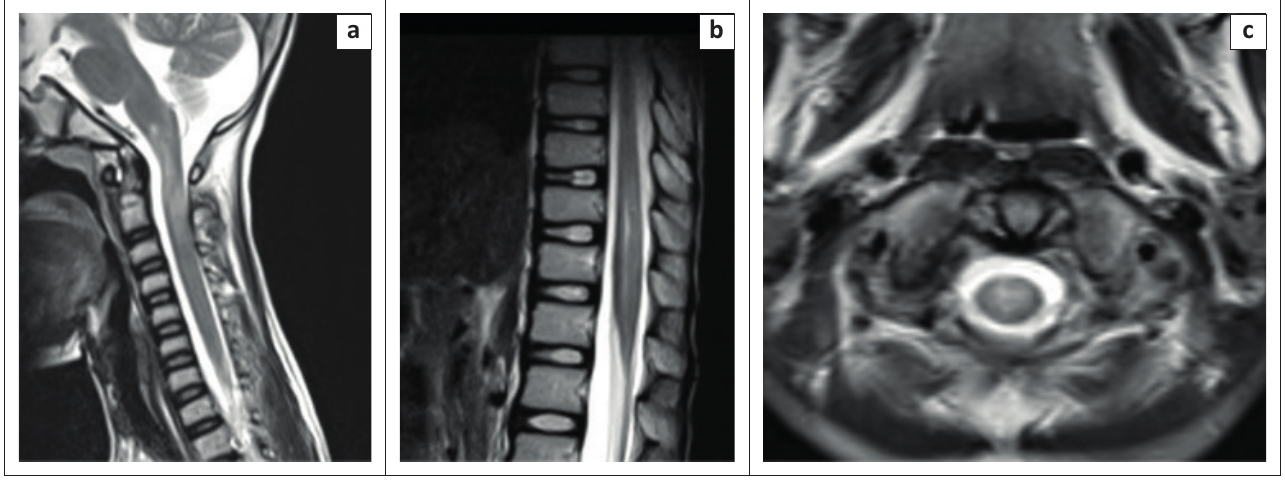
FIGURE 4: (a–c) [Case 2]: MRI screening of the spine in a 10-year-old male demonstrating T2 hyperintense signal in the inferior part of the medulla, cervicomedullary junction, upper cervical spinal cord, lower dorsal cord and conus